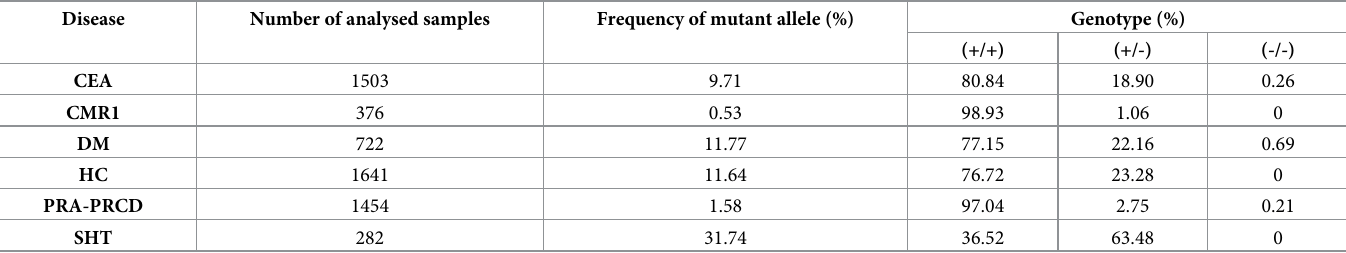
Table 2. Summarising the distribution of the mutant and wild-type allelic data of six disorders from all 2595 tested dogs. Disease Number of analysed samples